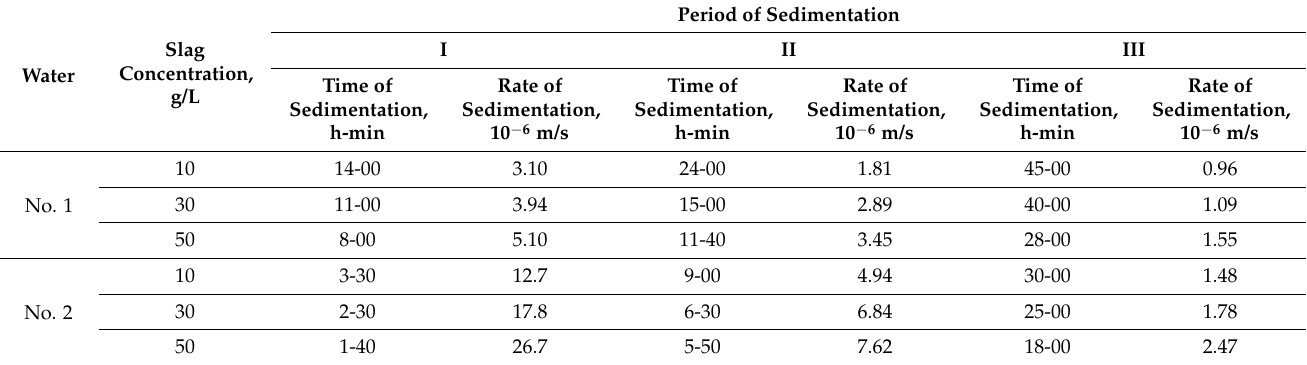
Table 20. Time and rate of sedimentation of slag particles in water dispersed medium of different hardness with plasticizer after ultrasonic